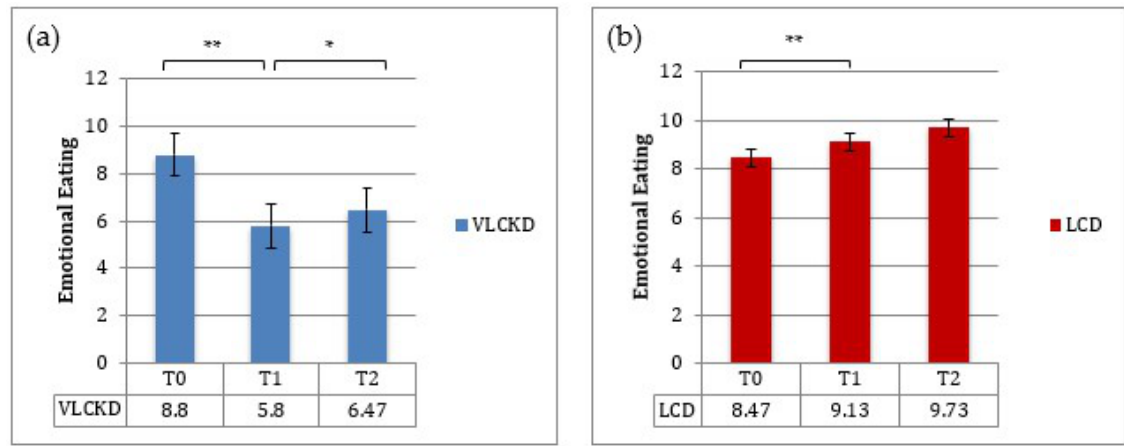
Figure 6. Mean scores (±SE) for emotional eating at baseline, T1 and T2: ( a ) VLCKD group; ( b ) LCD group. * p < 0.05; ** p < 0.001.